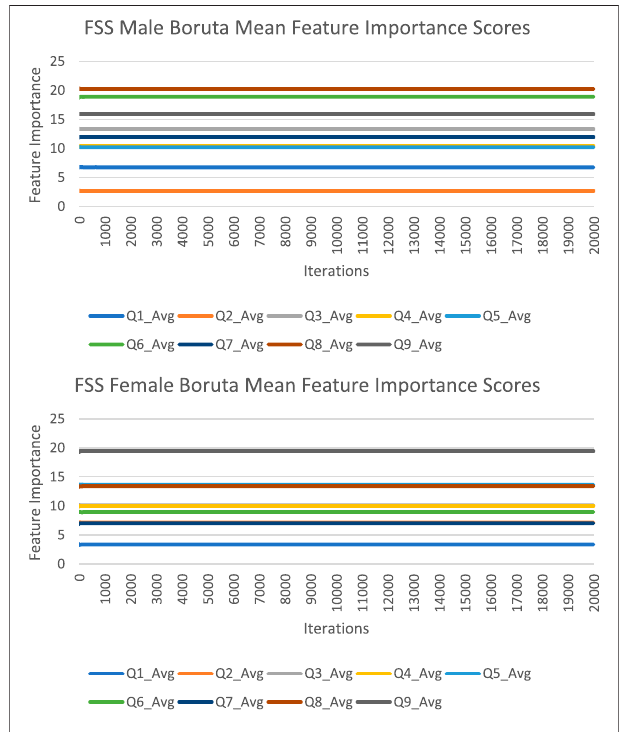
FIGURE 5 | FSS male and female Boruta mean feature importance score trends.